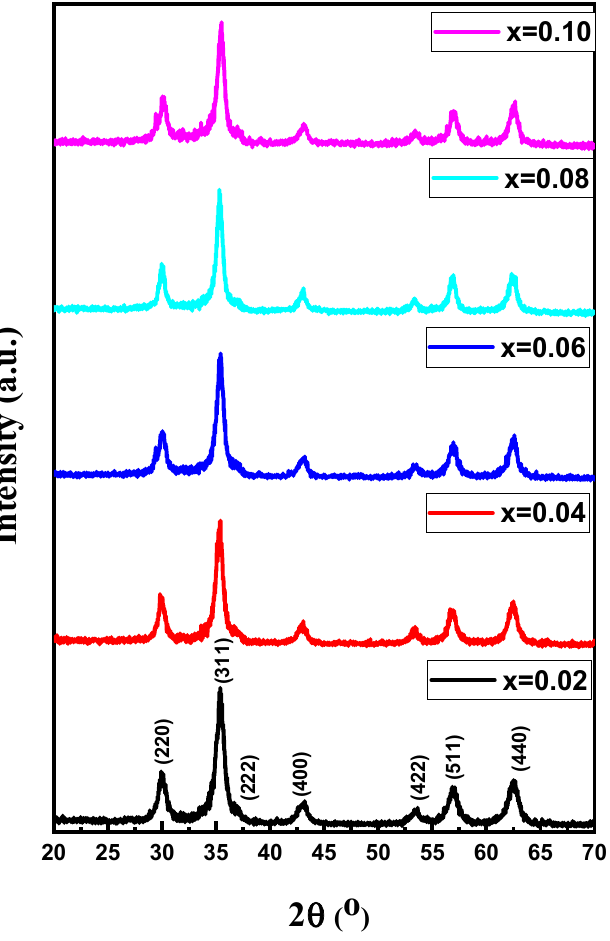
Figure 1. X-ray powder patterns of Mn 0.5 Zn 0.5 Er x Y x Fe 2-2x O 4 NPs (x = 0.02, 0.04, 0.06, 0.08, 0.10).